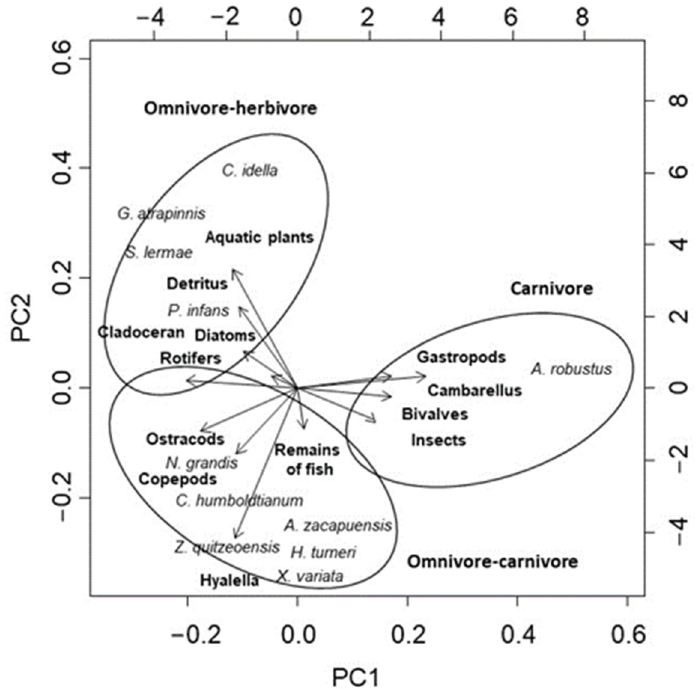
Figure 3. Principal component analysis showing the position of the trophic groups of fish species in Lake Zacapu.